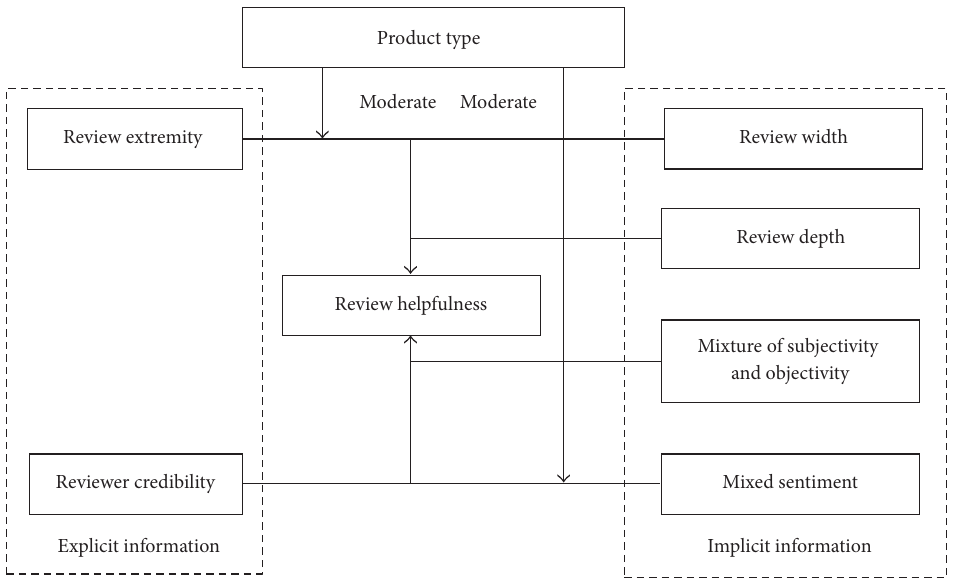
Figure 3: Conceptual framework of influencing factors of review